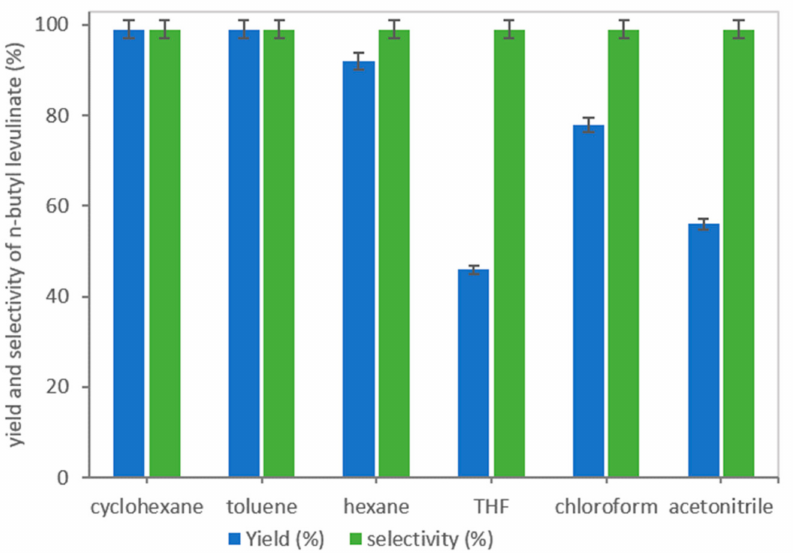
Figure 4. The effect of organic solvent on LA esterification. Reaction conditions: LA (0.117 g, 1 mmol); n -butanol (0.148 g, 2 mmol); biocatalyst CALB/MWCNT-PTFE (0.1 wt.%) (150 mg); solvent (1 mL); 20 ◦ C; 250 rpm, 60